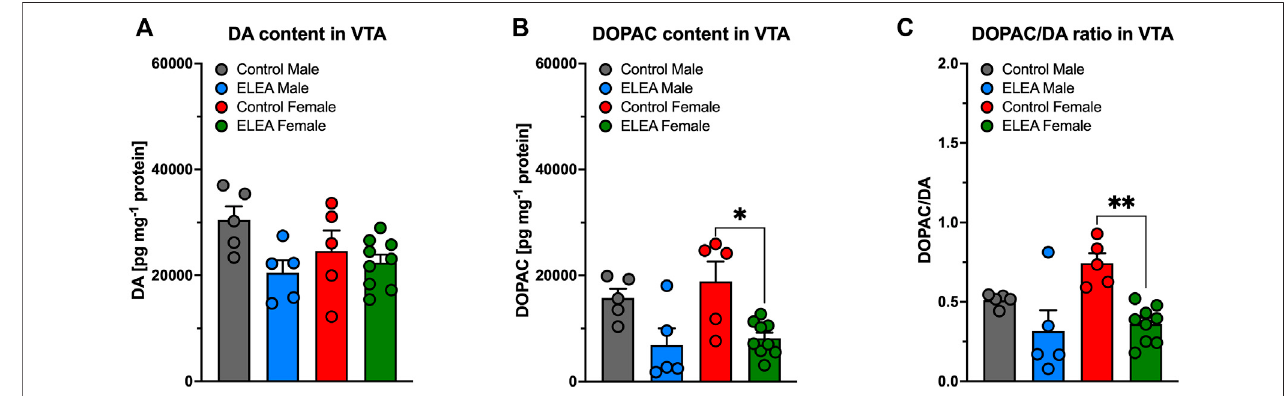
FIGURE 5 | DA and DOPAC content of VTA of early-life antibiotic exposed rats. ELEA did not alter VTA ’ s DA content of the adult rat (A) . However, antibiotic exposedfemales hadlower levelsofDOPACinVTA when injected withsalineduring CPP conditioning period (B) ,aswellaslowerDOPAC/DAratio (C) . (Control male,n = 6; ELEA male, n = 5; control female, n = 5; ELEA female, n = 9; * = p < 0.05; ** = p <